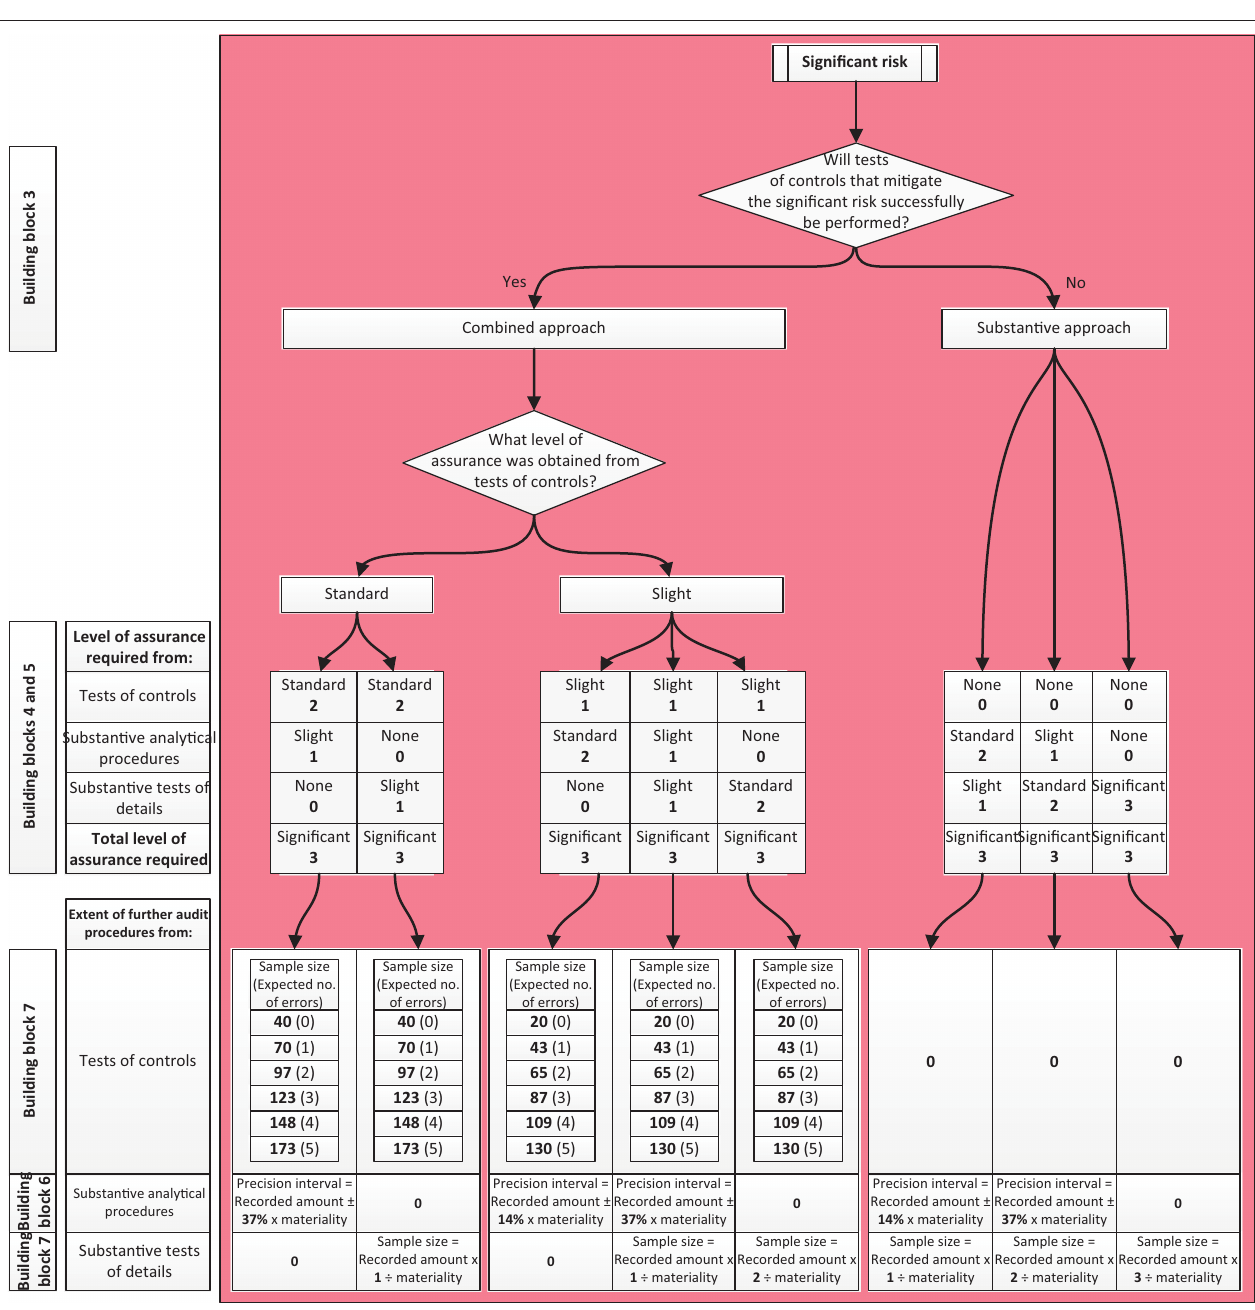
FIGURE 2: The integrated evidence planning model for significant risk assertions, classes of transactions, account balances and